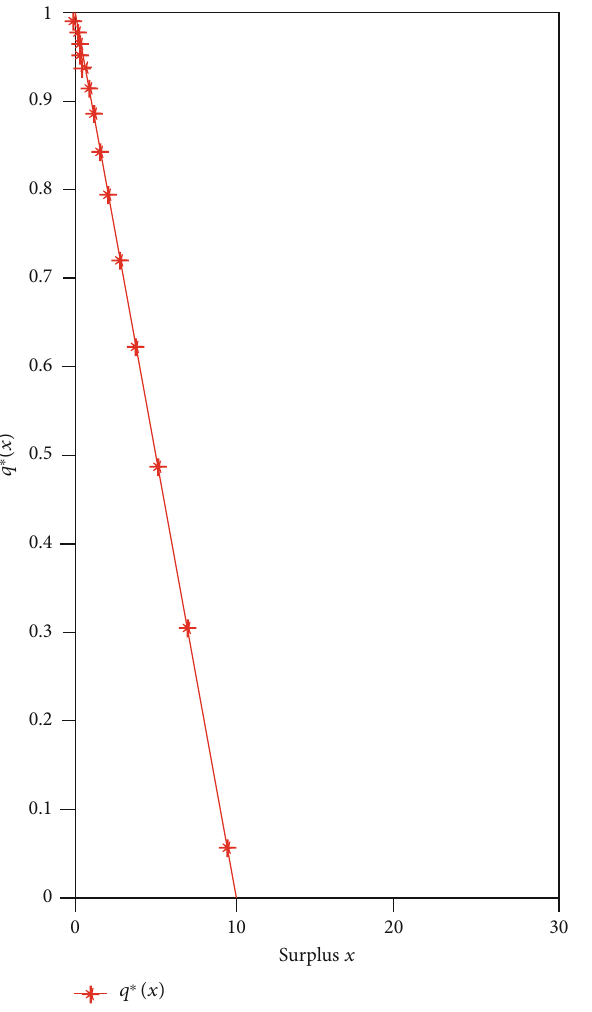
Figure 1: q ∗ ð x Þ and c ∗ ð x Þ change with x without VaR